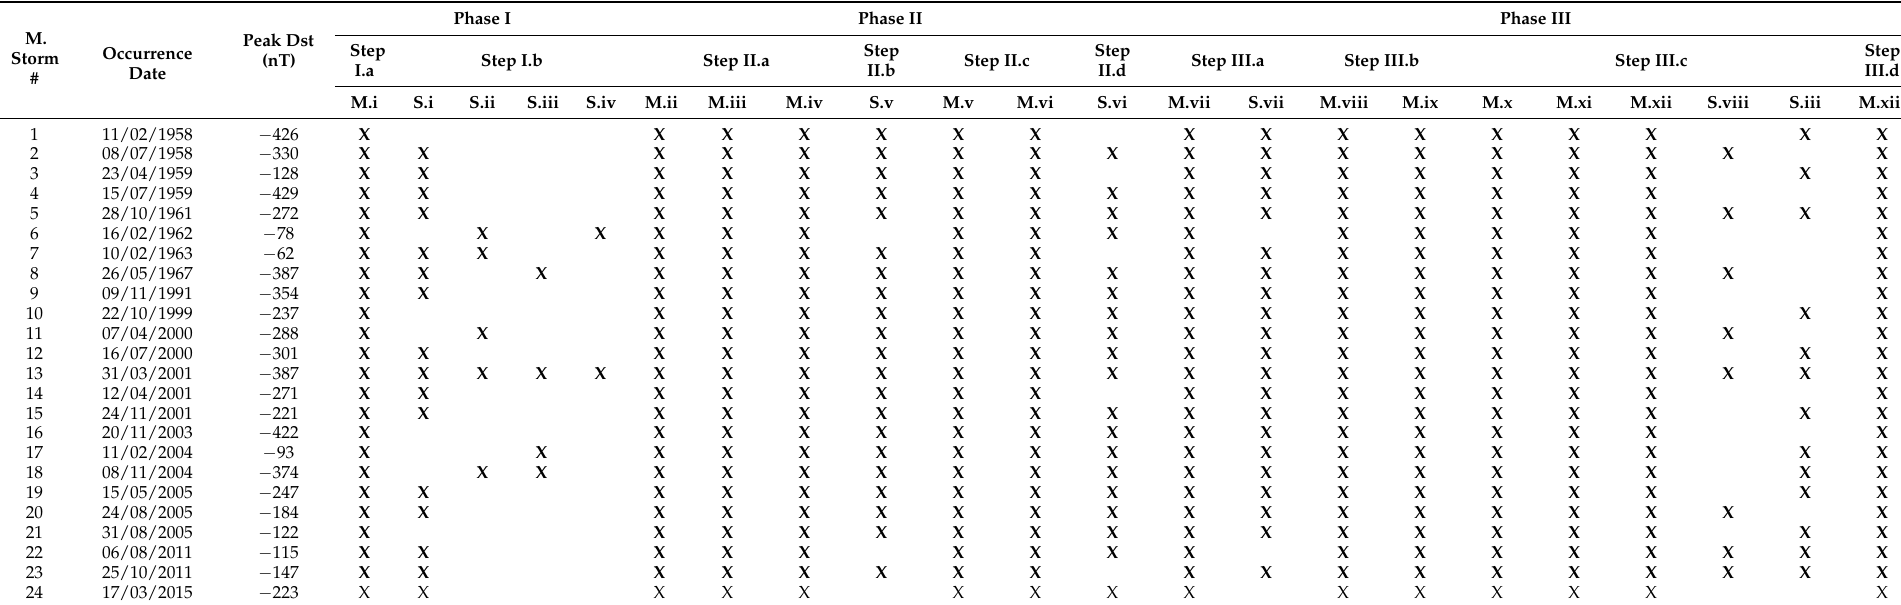
Table 1. List of the MSs which were analyzed using the analysis approach proposed in Section 3. Apart from the details of each MS (date/time of occurrence and peak D st value), the features (per phase and step) which were identified for each one of them are denoted. The notation used is the one defined in Section 3 for the phases, steps, and the numbering of main and secondary features. The identified features are denoted by an “X” mark. A set of 23 figures, showing the analysis of the MS included in Table 1, are available online as Supplementary